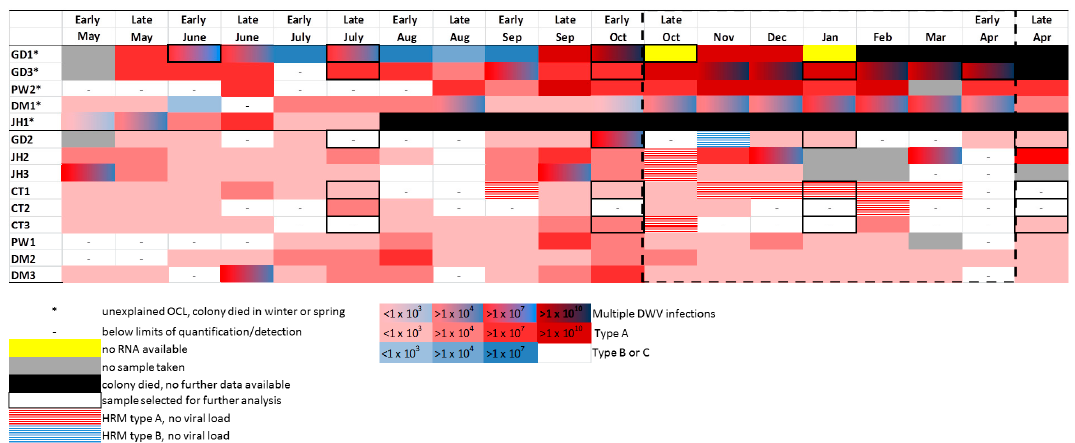
Figure 6. DWV load plus variant data as revealed by HRM for bee colonies sampled in Devon, in the southwest of England (Shute, Honiton, Plymouth, Ashburton, and Newton Abbot), over a year (bimonthly between May and October 2006, monthly between November 2006 and March 2007, and bimonthly in April 2007) as described in the Highfield et al. study [21]. The DWV variants are displayed by colours: red = DWV type A, blue = DWV type B or C, and the shade of the colour relates to the viral load; light colours represent low viral loads, dark colours represent high viral load. Table 3. ABC assay data alongside its respective HRM analysis on a reduced dataset (Figure 6). DWV variant type and viral loads (darker shades indicated relative high viral loads) are displayed for each sample.